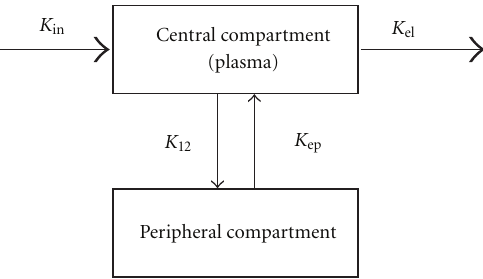
Figure 4: Schematic illustration of the Brix model. The model is a linear two-compartment open model, where the peripheral compartment has only negligible e ff ects on the central compartment. K ep : the exchange rate constant from the EES to plasma, K el : the elimination constant of the CM from the central compartment, and AH: the amplitude scaling